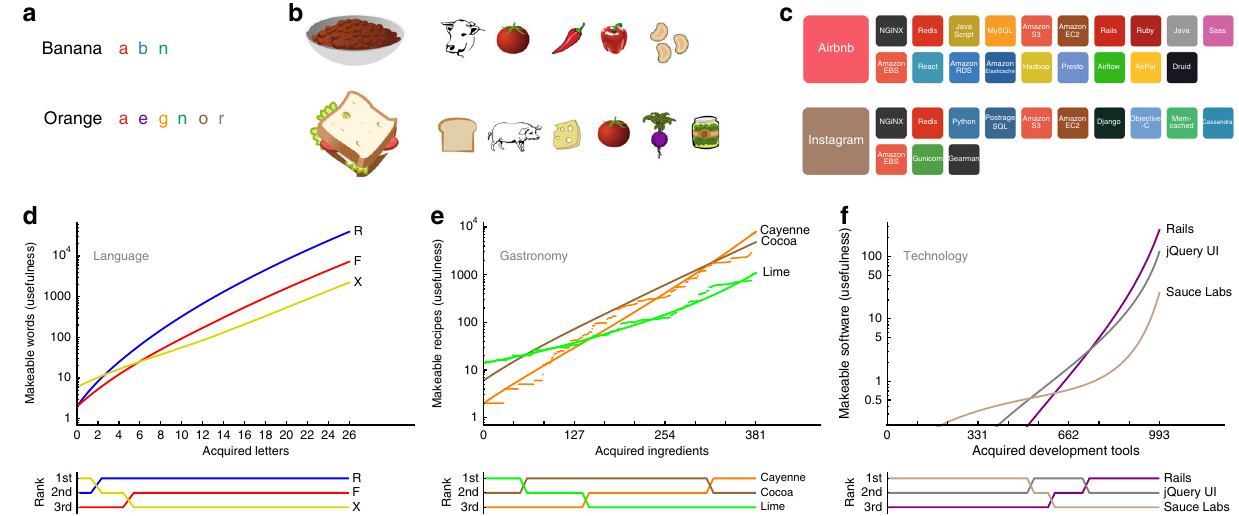
Fig. 1 Products, components and usefulness for three sectors. We studied products and components from three sectors. a In language, the products are 79,258 English words and the components are the 26 letters. b In gastronomy, the products are 56,498 recipes from the databases allrecipes.com, epicurious.com and menupan.com 23 , and the components are 381 ingredients. c In technology, the products are 1158 software products catalogued by stackshare.io and the components are 993 development tools used to make them. d – f The usefulness of a component is the number of products we can make that contain it. We fi nd that the relative usefulness of a component depends on how many other components have already been acquired. For each sector, we show the usefulness of three typical components: averaged at each stage over all possible choices of the other acquired components and — for gastronomy — for a particular random order of component acquisition